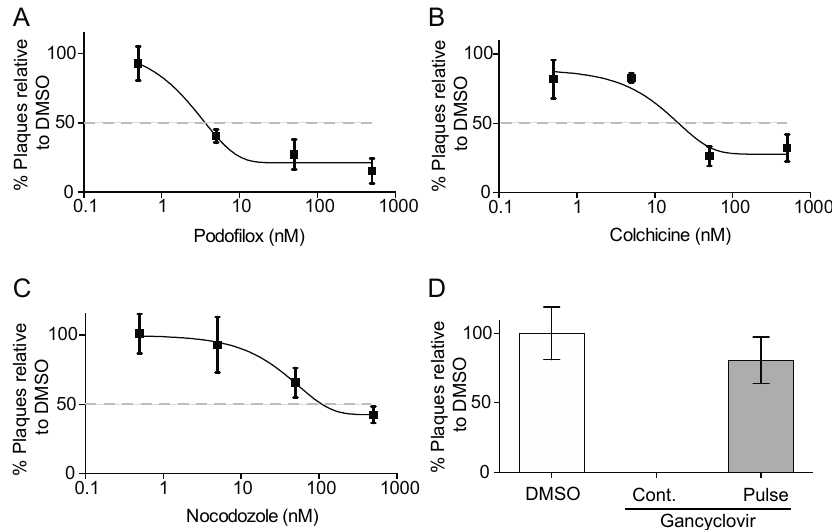
Figure 1. Microtubule inhibitors limit viral dissemination. MRC5 cells pre ‐ treated with 0.5, 5, 50, and 500 nM of podofilox ( A ); colchicine ( B ); nocodazole ( C ) or ganciclovir (12 μ M) ( D , Pulse) were infected with AD169IE2 ‐ YFP (MOI 0.1) for 2 h. The cells were washed and analyzed for plaques 7 d p.i. As a control, cells were continuously (Cont.) treated with ganciclovir (12 μ M) ( D ). The % Plaques was determined using DMSO ‐ treated cells as 100%. The error bars represent the standard deviation from six replicates.